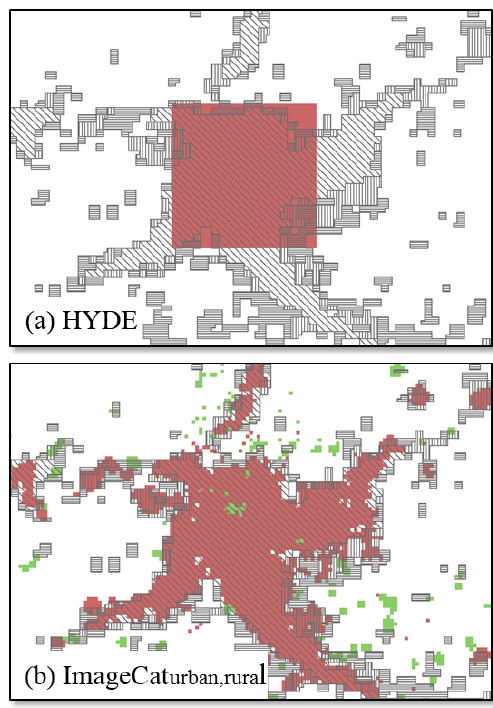
Figure 6. Addis Ababa mapped by (a) HYDE as used in GLOFRIS with above 0% urban built-up cell (red); (b) classified ImageCat data: urban (red) and rural (green); GHS-SMOD rural (horizontal), urban cluster (vertical), and urban centre (diagonal) as background boundary